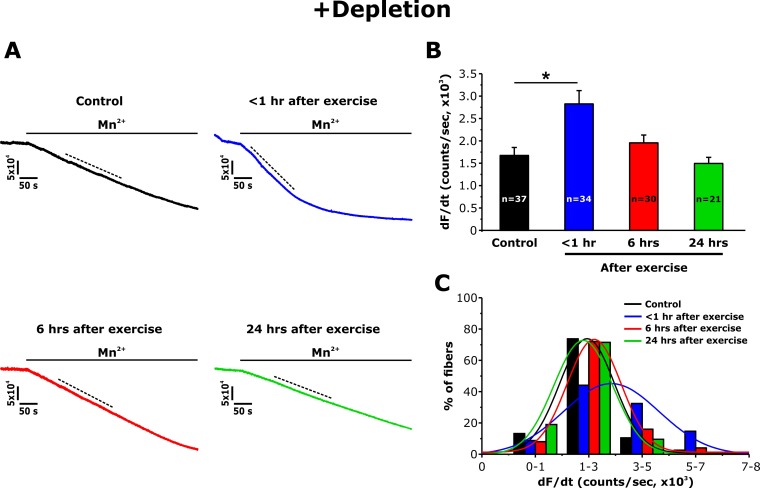
Effect of exercise on the maximum rate of Mn2+ quench following store depletion.(A) Representative traces of fura-2 fluorescence during application of 0.5 mM Mn2+recorded in FDB fibers following store depletion with 1 μM thapsigargin + 15 μM cyclopiazonic acid (+depletion) isolated from control mice and from mice < 1 hr, 6 hr, and 24 hr after acute treadmill exercise. (B) Quantitative analysis of the maximum rate of Mn2+ quench following store depletion. (C) Frequency histogram of percentage of fibers exhibiting different levels of maximal rate of Mn2+ quench. Histogram data were fit with a single Gaussian distribution. Numbers in bars (n) reflect the number of FDB fibers analyzed. Number of mice used: Control, n = 5;<1 hr after exercise, n = 5; 6 hr after exercise, n = 3; 24 hr after exercise, n = 3; *p<0.05. Data are shown as mean ± SEM.